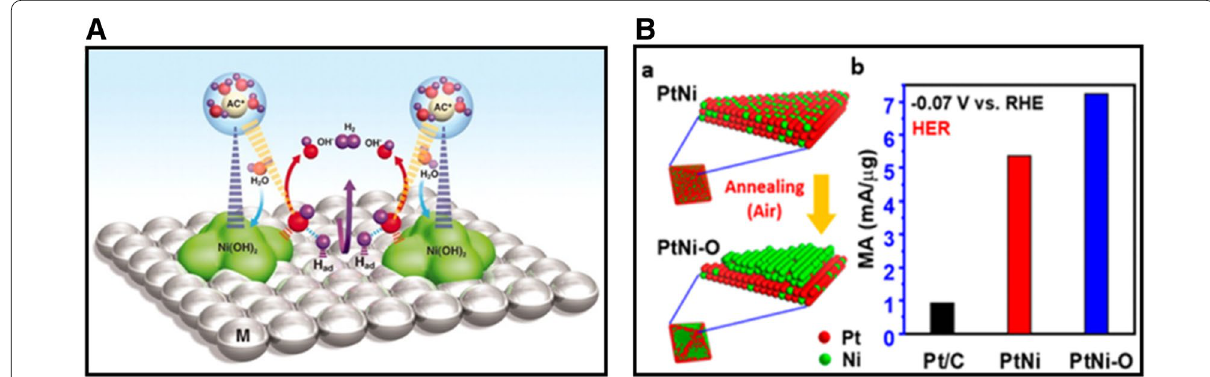
Fig. 4 A Schematic illustration of the mechanism of HER on nanometer‑scale Ni(OH) 2 clusters on Pt electrode surface (Figure reprinted with permission from Ref. [48]). B (a) Schematic illustration of the transformation of PtNi/C to PtNi–O/C via annealing in air, and (b) comparison of HER mass activities at 0.07 V vs RHE (Figure reprinted with permission from Ref. −